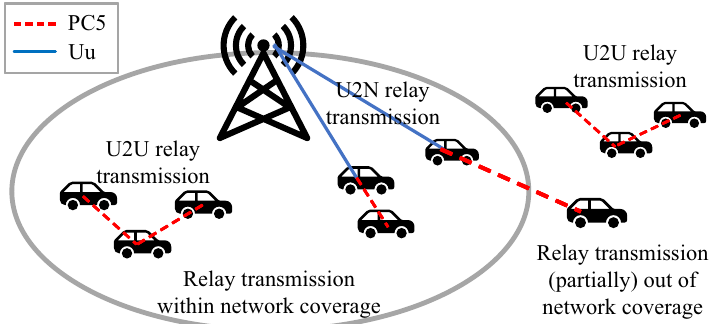
Fig. 1 Communication modes of sidelink